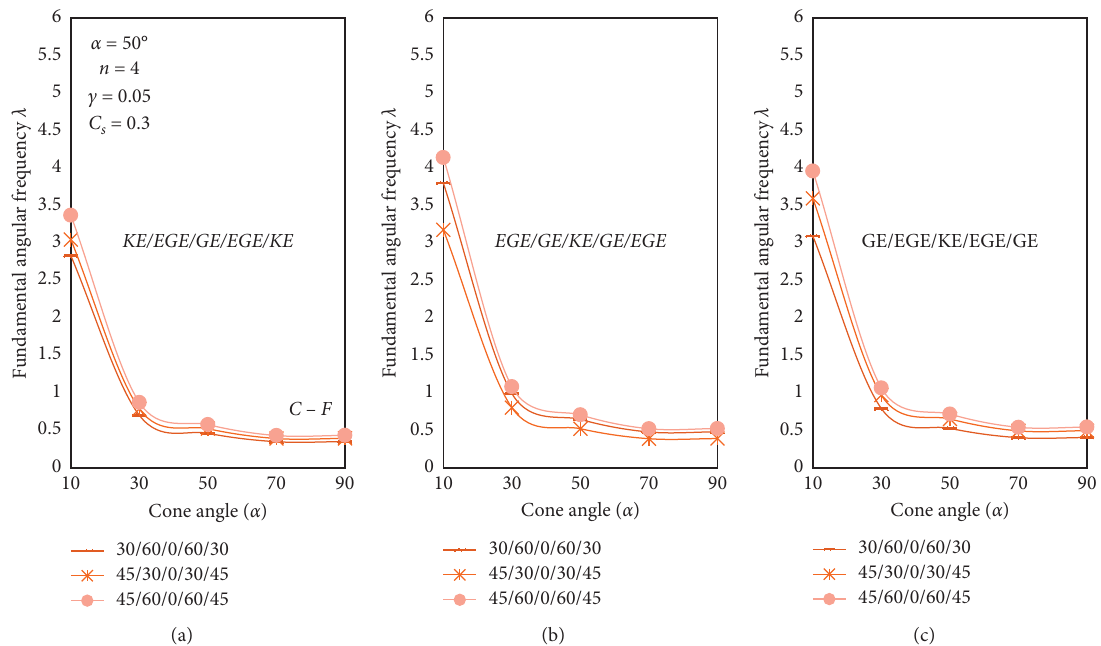
Figure 15: Influence of cone angle on the fundamental frequency parameter of five-layered conical shells with different material combinations.